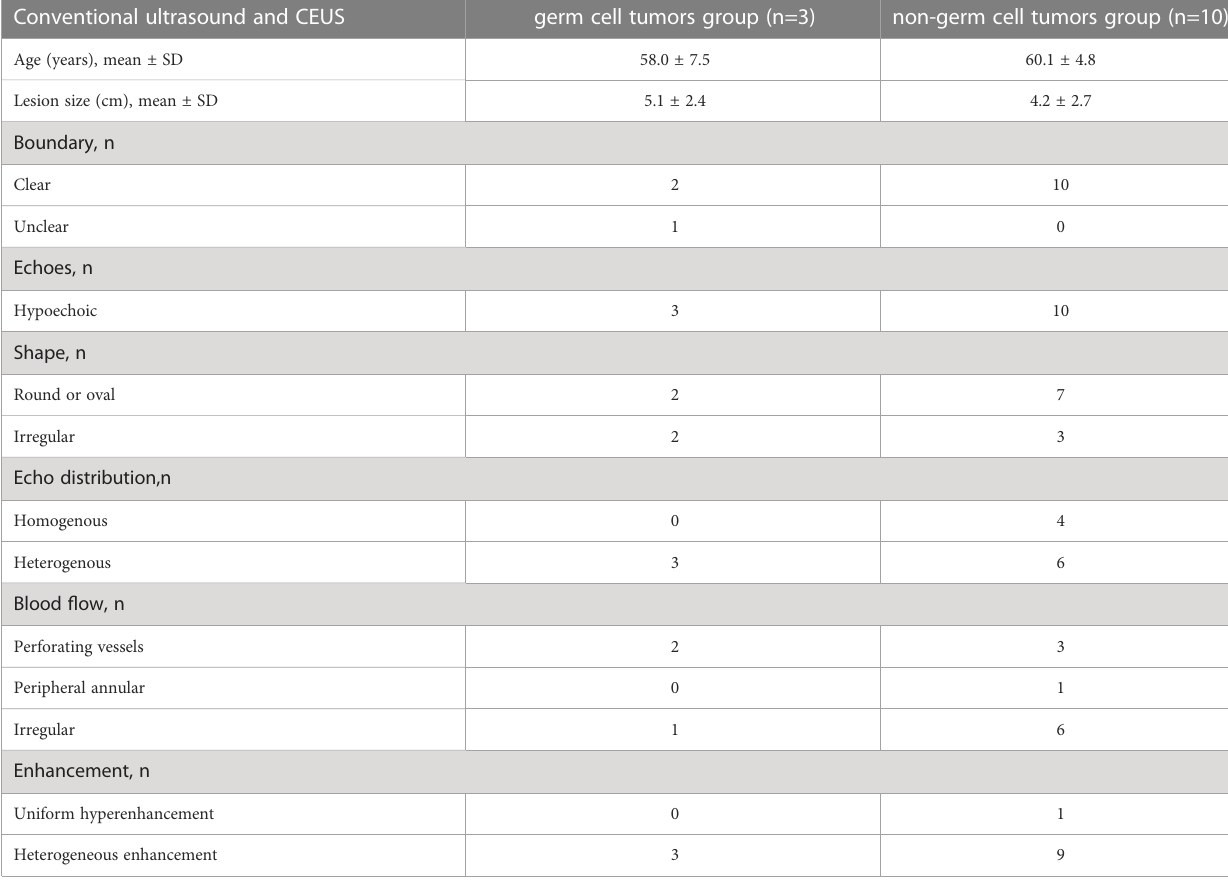
TABLE 1 Conventional ultrasound and CEUS features of testicular germ cell tumors and non-germ cell tumors over 50 years old. Conventional ultrasound and